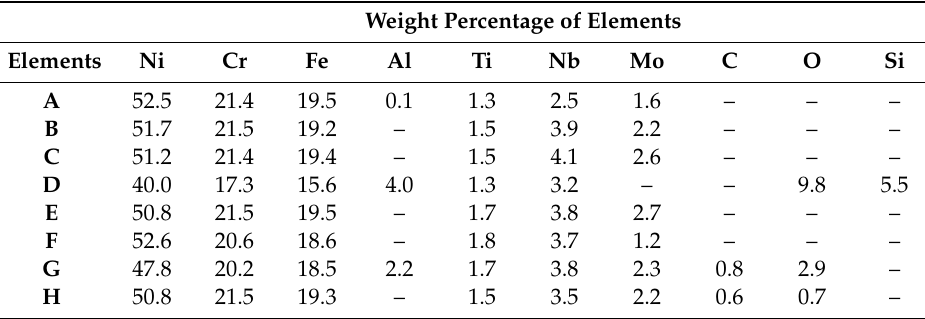
Table 2. Elemental analysis of regions / particles present in the sample.